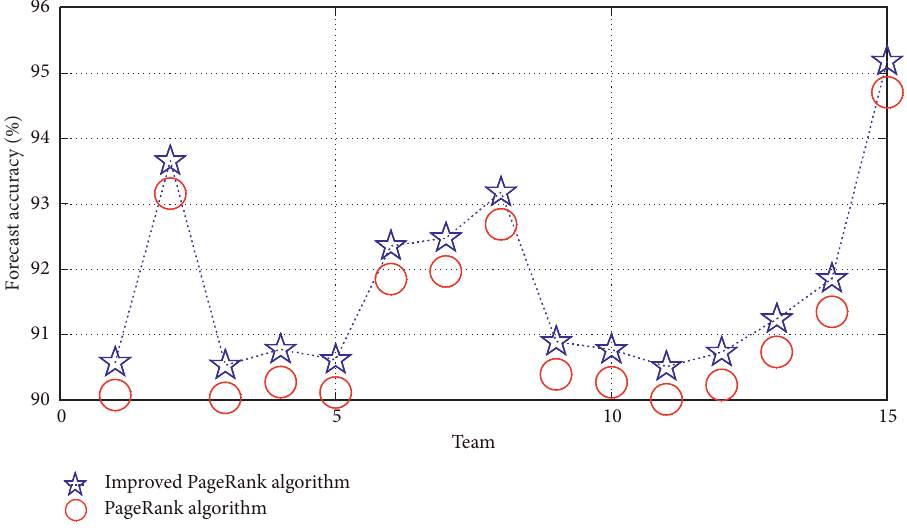
Figure 5: Team’s PR and winning numbers in the western division. Table 2: Comparison of the actual results and the two methods.